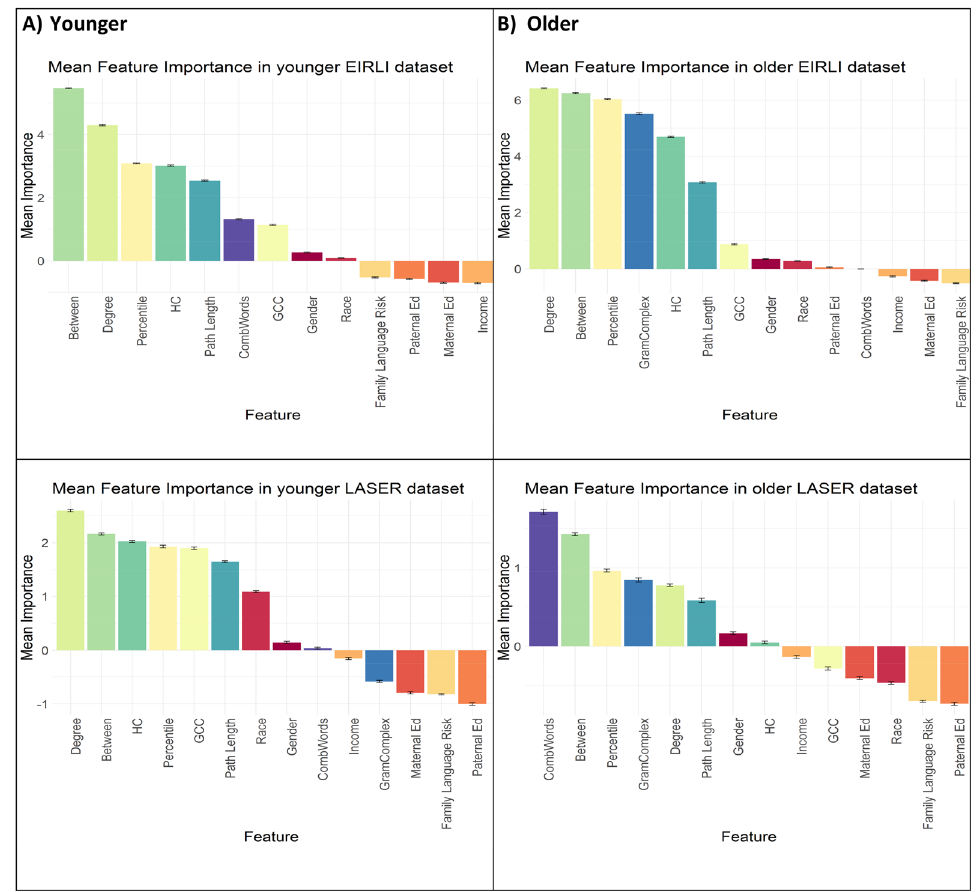
Figure 1. Feature importance rankings across younger and older datasets.